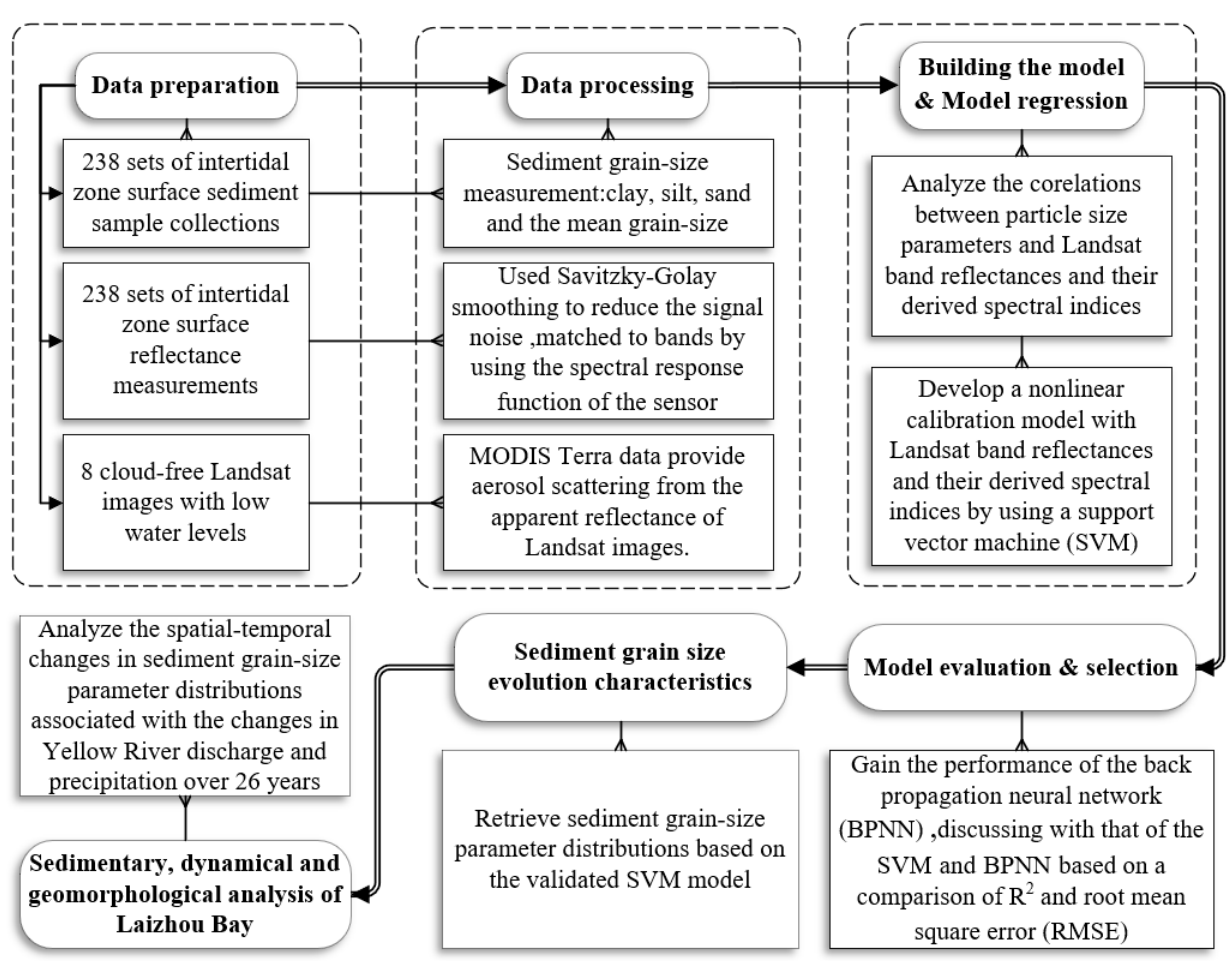
Figure 1. A flow diagram of the methodological steps.